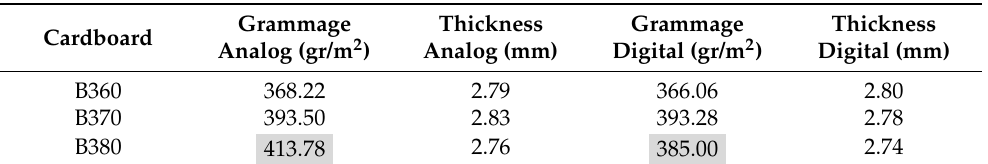
Table 1. Grammage and thickness of all cardboard samples.